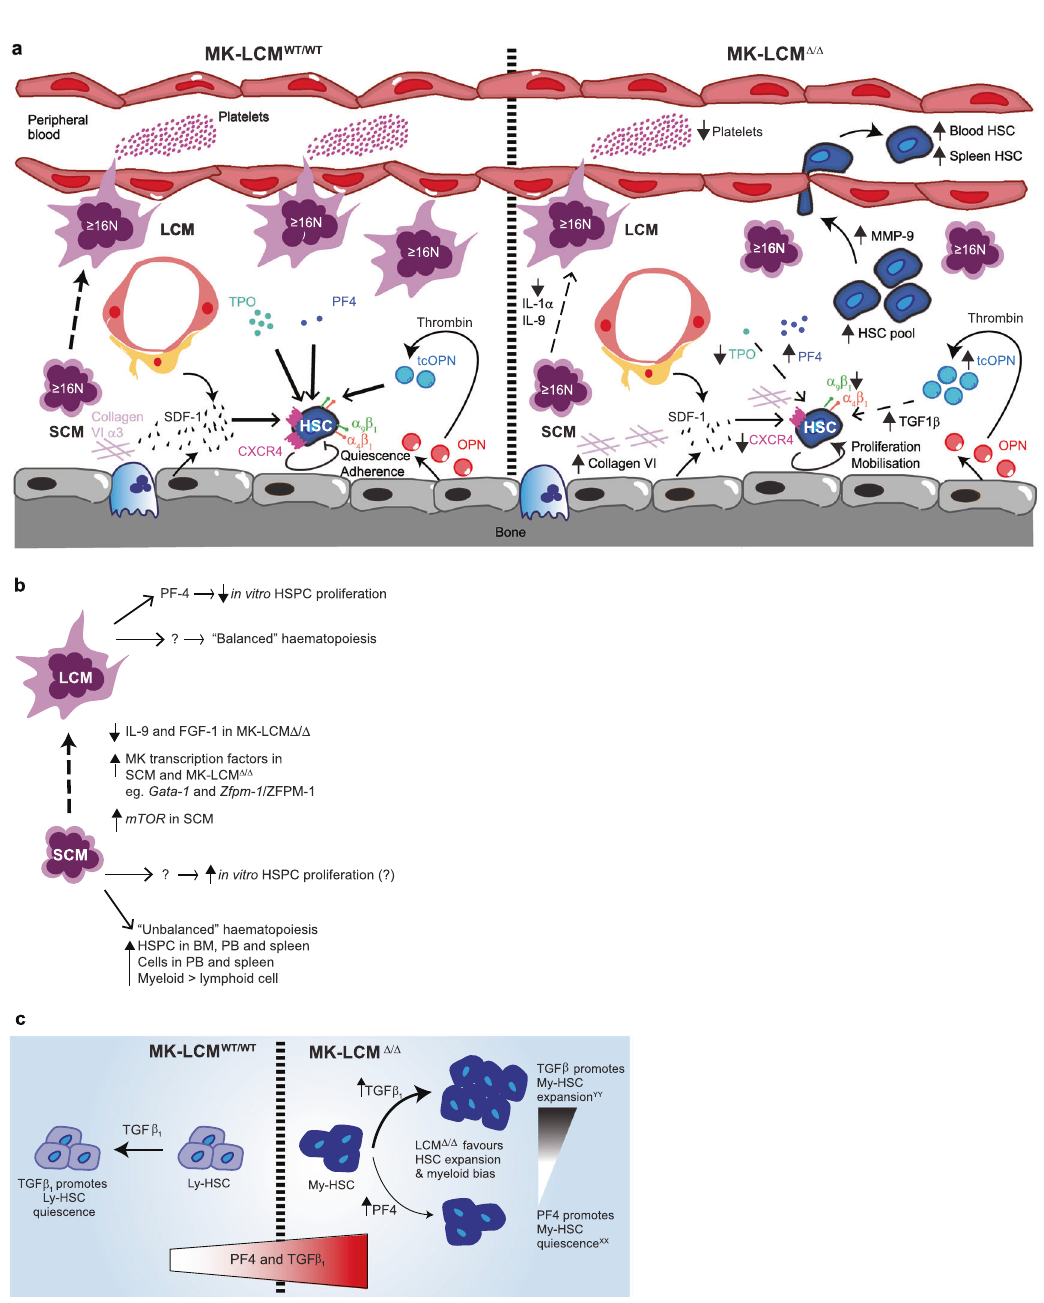
Fig. 6 | Models of MK:HSC interactions in BM. a Schematic depicting several mechanisms by which a loss of BM LCM results in increased BM hematopoietic stem and progenitors, endogenous mobilisation and splenomegaly. b Schematic